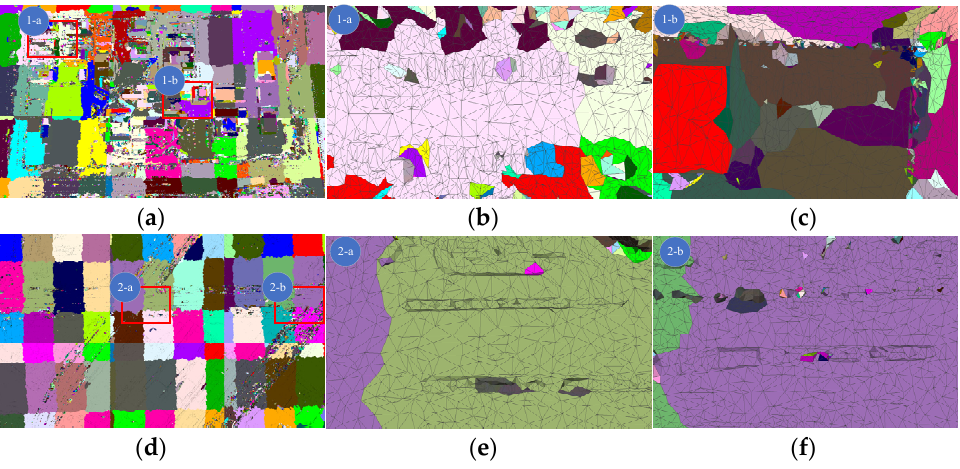
Figure 17. Texture charts obtained via the method proposed in this article. ( a ) texture charts for building area; ( b , c ) the texture charts of building area via the method proposed in this article; ( d ) texture charts for non-building area; ( e , f ) the texture charts of non-building area via the method proposed in this article. red frame is the local detail area; red circle is the experimental comparison